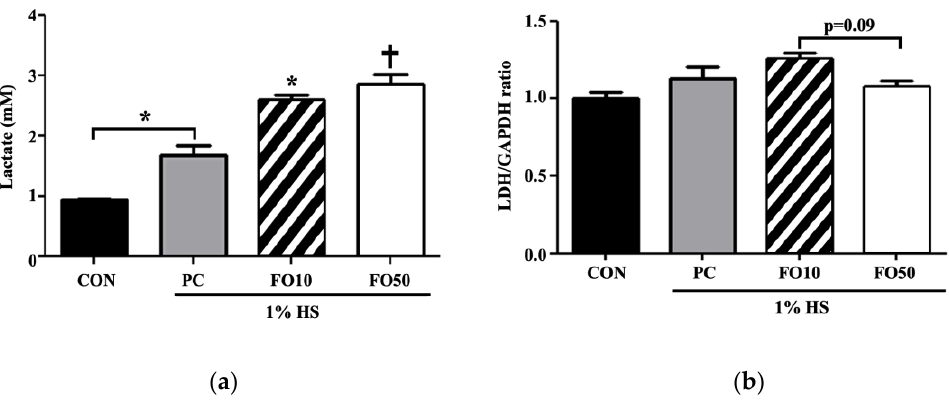
Figure 4. Changes in ( a ) lactate and ( b ) lactate dehydrogenase levels were determined in C2C12 muscle cells following administration of 10 and 50 μg/mL of FO. Each bar represents the mean ± standard deviation (SD). A one-way analysis of variance (ANOVA) test was carried out to determine significant differences (* p < 0.05, † p < 0.001) between groups.